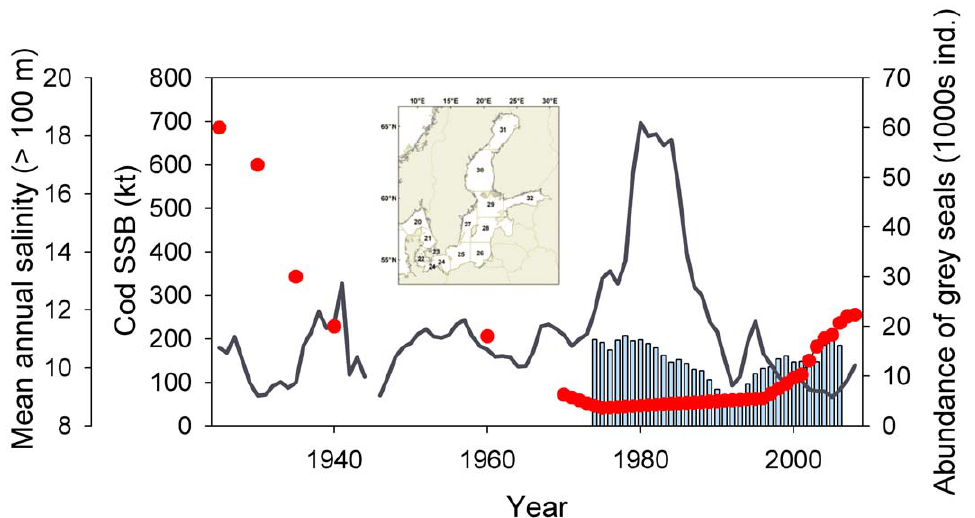
Figure 1. Temporal development of cod spawner biomass [ 52 ] (line), salinity in the deep layer of the Baltic Sea ( . 100 m in Landsort Deep; bars [ 31 ] ) and grey seal abundance in the Baltic Sea (red circles ) [ 42 ] . Inset shows map of the Baltic Sea with ICES Subdivisions indicated.